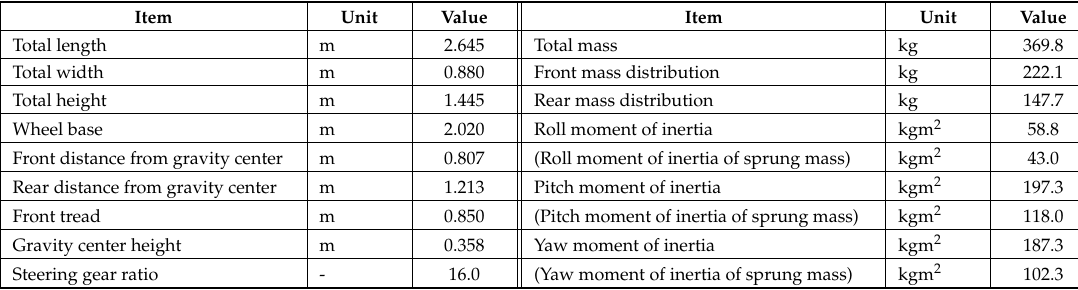
Figure 3. Dimensions of model vehicle. Table 2. Specifications of model vehicle.